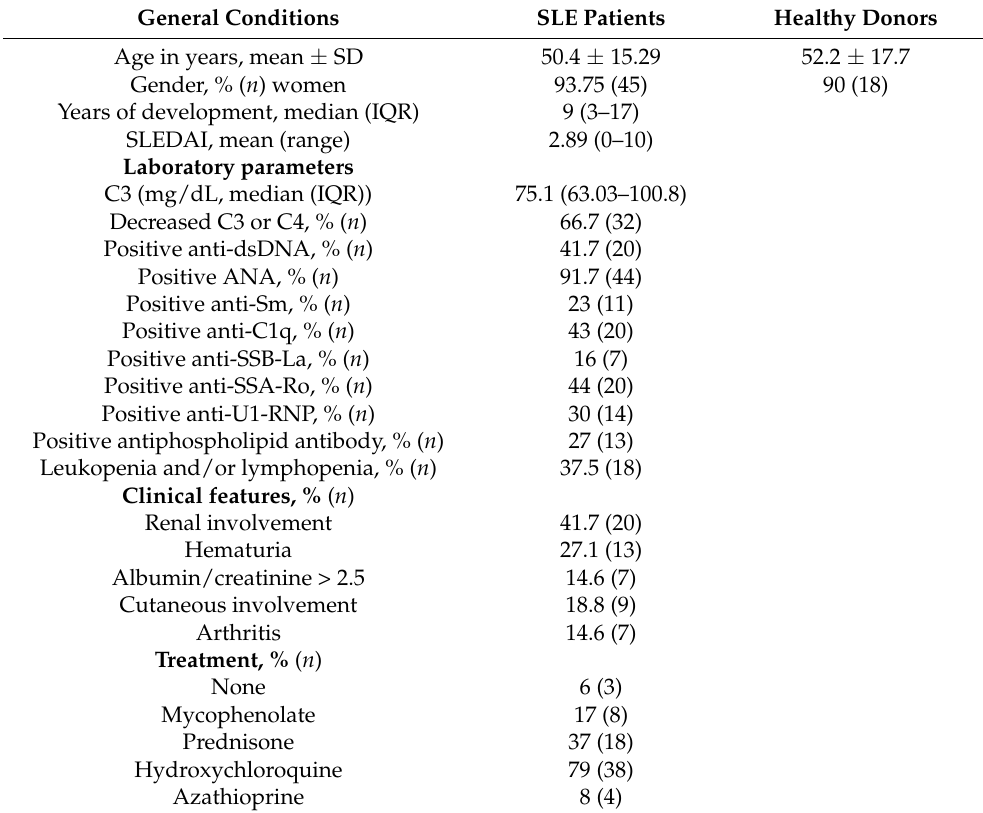
Table 1. Demographic, clinical and laboratory characteristic data of study